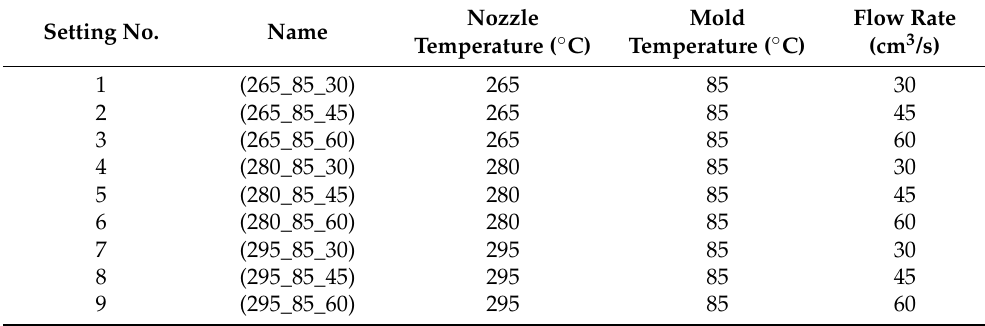
Table 2. Experimental design for the manufacturing of the test specimens by injection molding. Setting